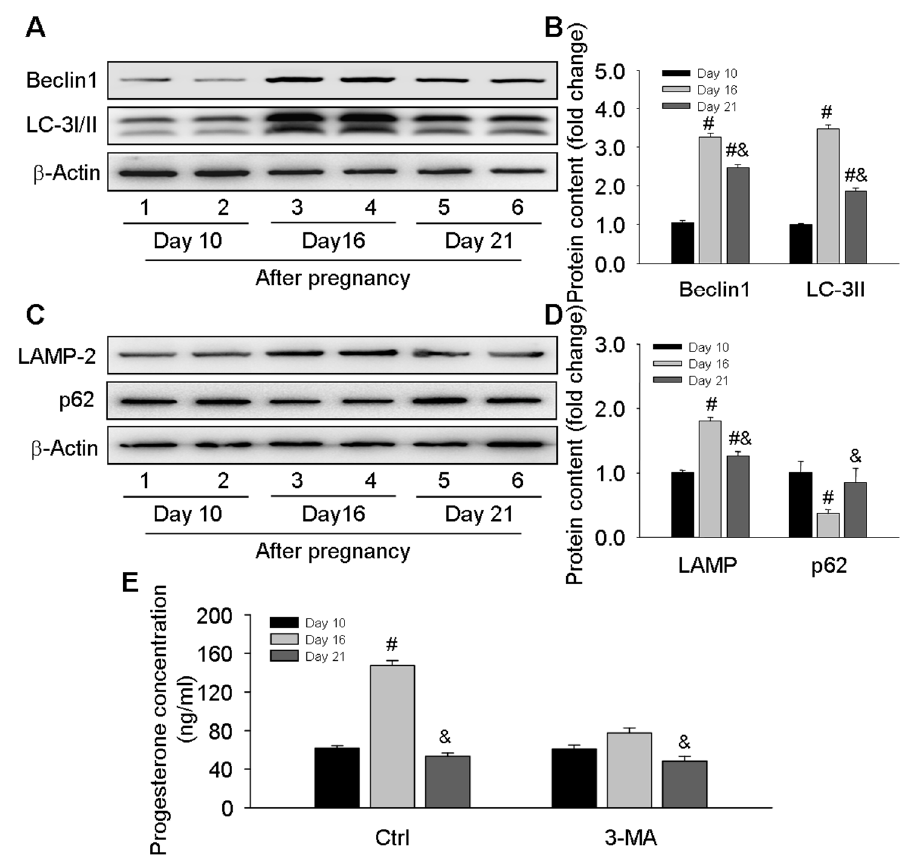
Figure 2. Changes of ovarian-autophagy-related protein levels and serum progesterone concentrations during the luteal development of pregnant rats: ( A ) representative western blot analyses depicting the protein levels of Beclin1 and LC-3; ( B ) summarized intensities of Beclin1 and LC-3II blots normalized to the control; ( C ) representative western blot analyses depicting the protein levels of LAMP-2 and p62; ( D ) summarized intensities of LAMP-2 and p62 blots normalized to the control; ( E ) serum progesterone levels. Each value represents the mean ± SE, n = 6. ANOVA was used to analyze the data. #: p < 0.05 vs. p on day 10, &: p < 0.05 vs. p on day 16. 3-MA: an autophagy